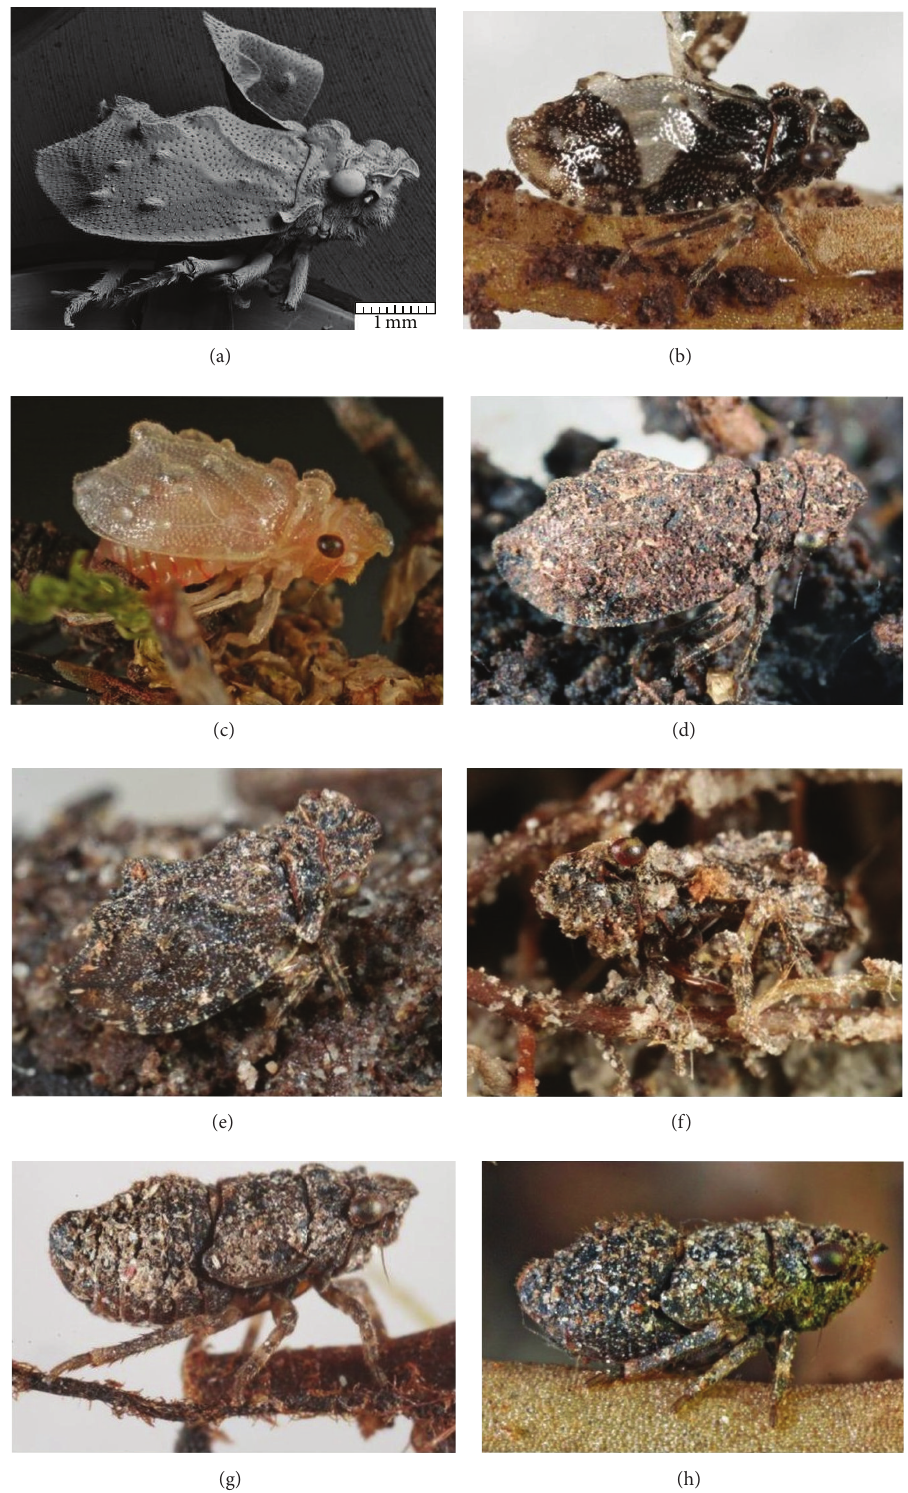
Figure 1: Mapuchea chilensis . ((a), (b), (c), and (d)) Specimens from the Huerquehue NP. (a) Scanning electron image of a female molted in captivity and not camouflaged with soil; the left tegmen is mangled. (b) The same specimen live, showing color pattern. ( c ) Freshly molted female. (d) Camouflaged specimen. (e) Specimen from the Puyehue NP. (f) Soil camouflage in combination with disruptive coloration of legs makes this specimen hard to see; note that the eyes remain clean. (g) 5th instar nymph. (h) 3rd instar nymph. All photos of live specimens were taken in